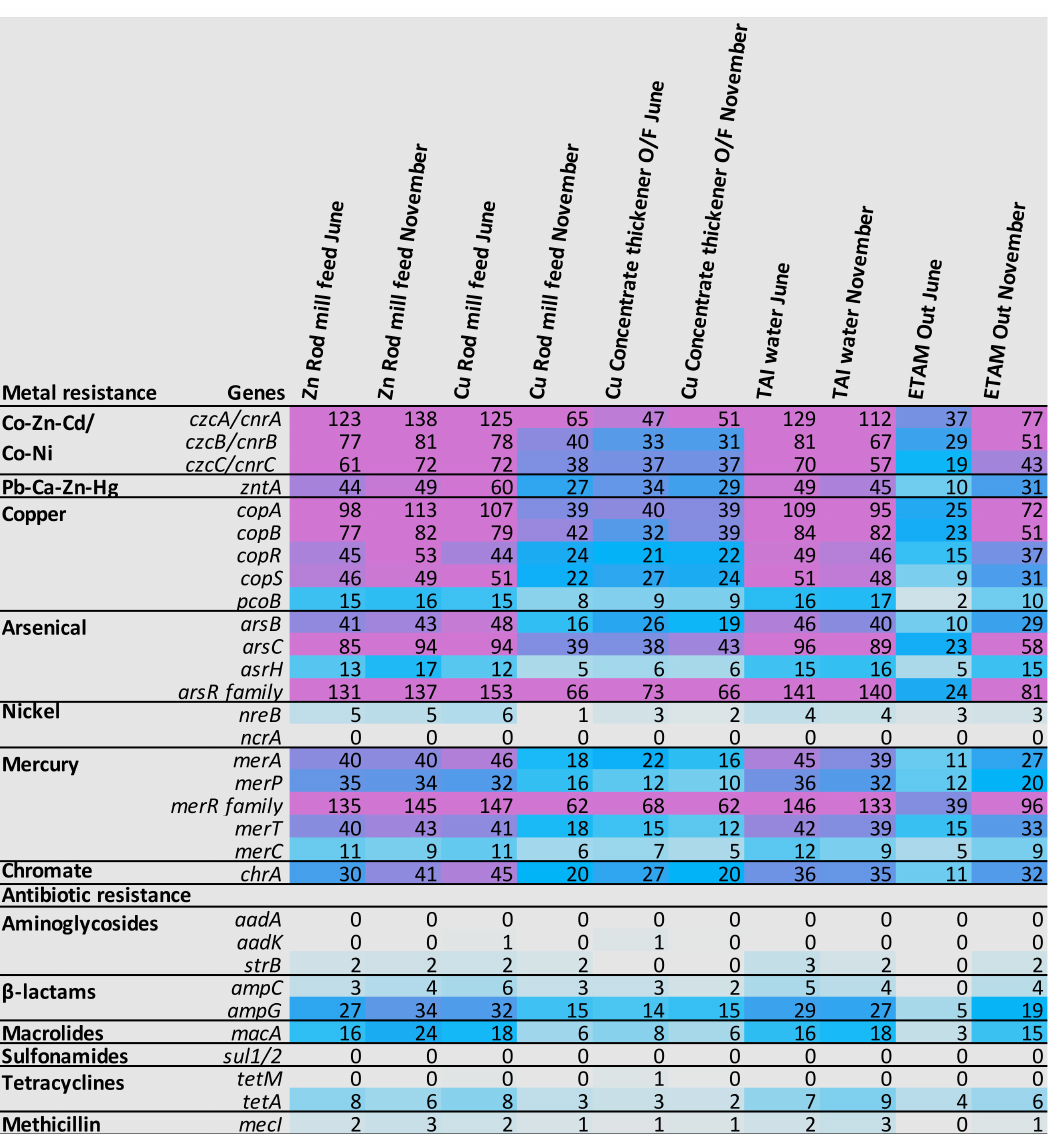
Figure 11. Heavy metal and antibiotic resistance-related genes from each sample from the annotated metagenomic “detection” data. The colors highlight the gene amounts and start to change from grey to blue with the first detected gene and from blue to purple after 20 detected genes. No color change after 50 detected